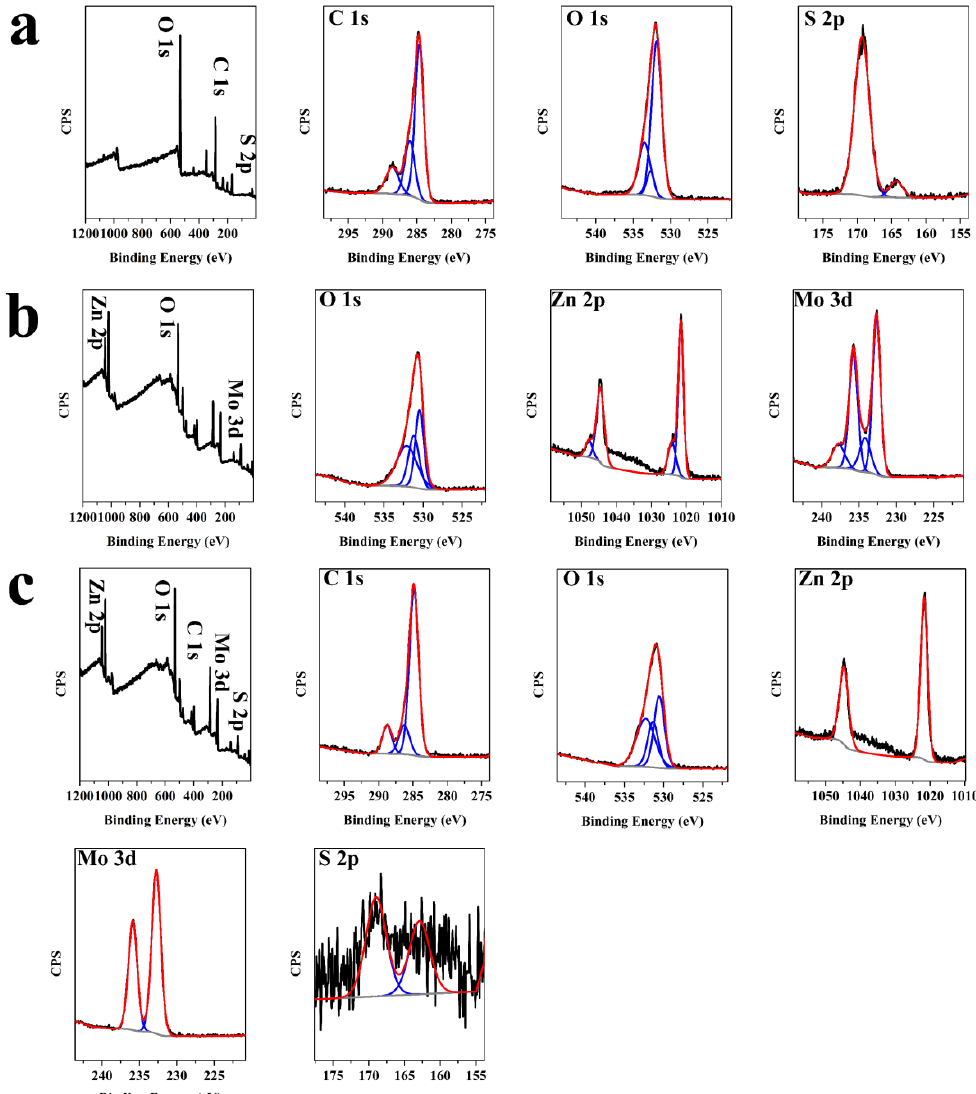
Figure 3. XPS spectra and high resolution XPS spectra of C 1s, O 1s, Zn 2p, Mo 3d, S 2p of ( a ) SG, ( b ) ZMO, and ( c ) SZMO@SG.